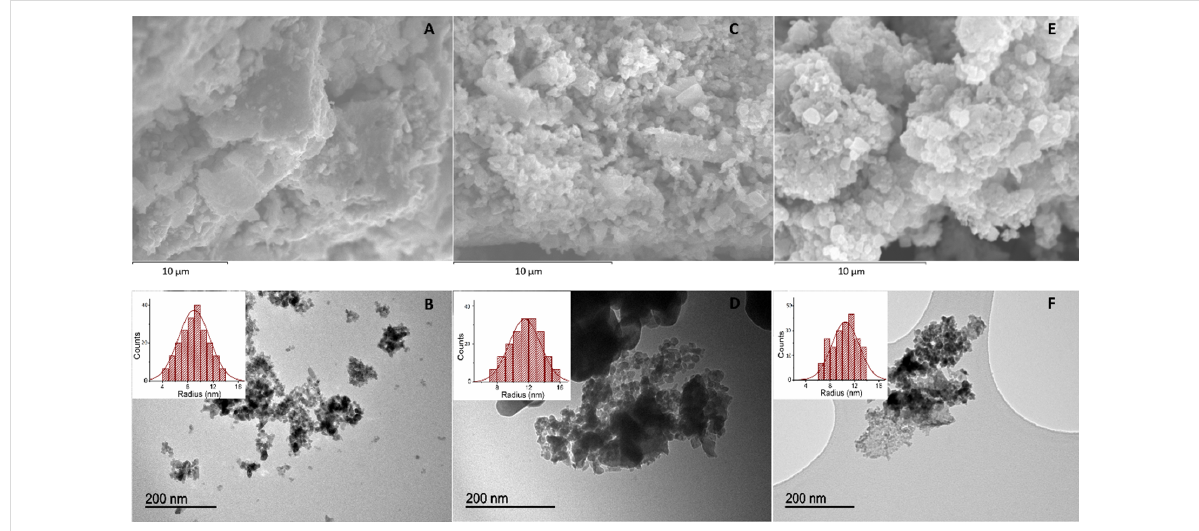
Figure 3: A and B: SEM and TEM images of TiO 2 -Fe 2 O 3 -PS4; C and D: SEM and TEM images of Fe 2 O 3 -PS4. E and F: SEM and TEM images of Fe